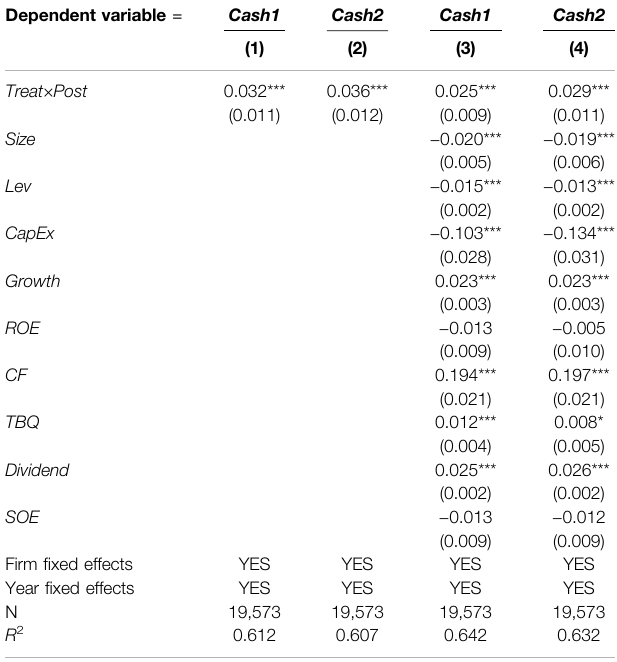
TABLE 3 | Environmental regulation and corporate cash holdings.